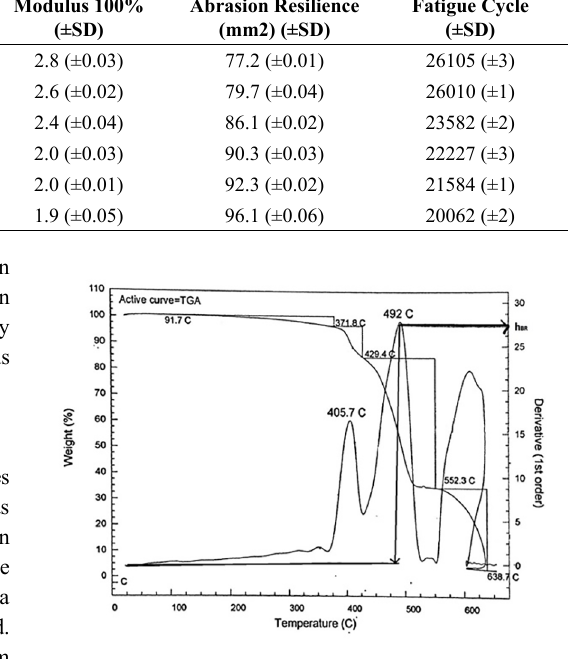
Table 3. Mechanical properties of BR/SBR rubber samples aged for different days Aging (Day)